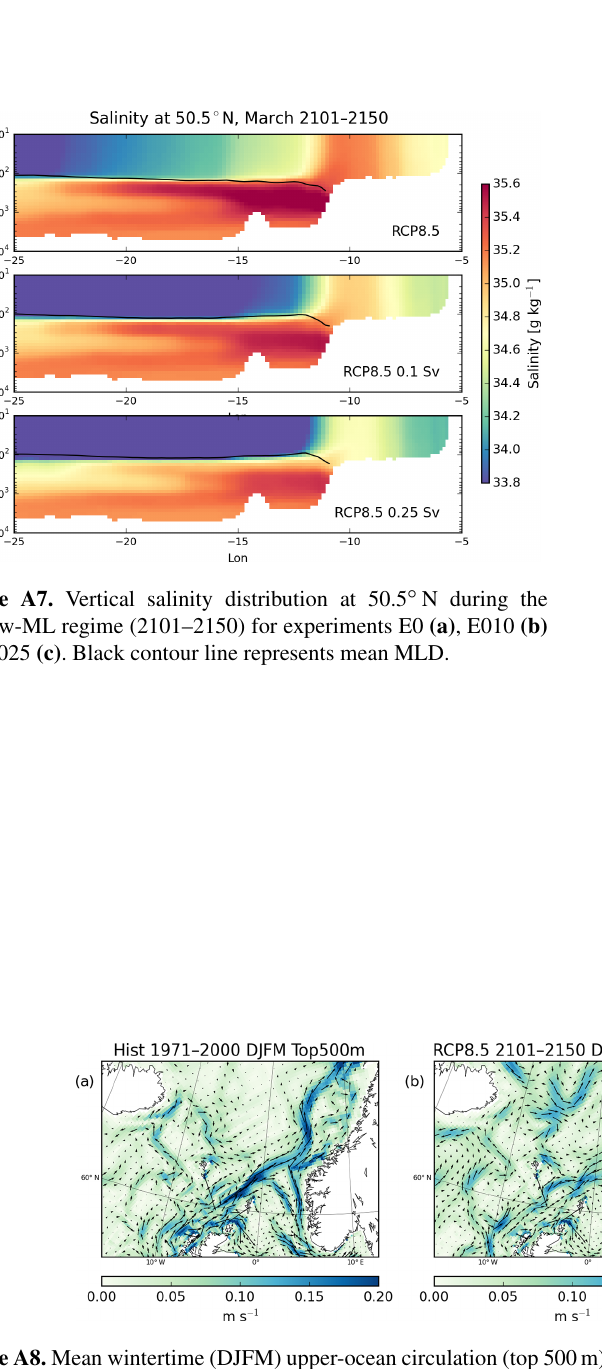
Figure A8. Mean wintertime (DJFM) upper-ocean circulation (top 500m) in the Norwegian Sea during the historical period (1971–2000) (a) and the shallow-ML regime (2101–2150) according to experiments E0 (b) and E010 (c)